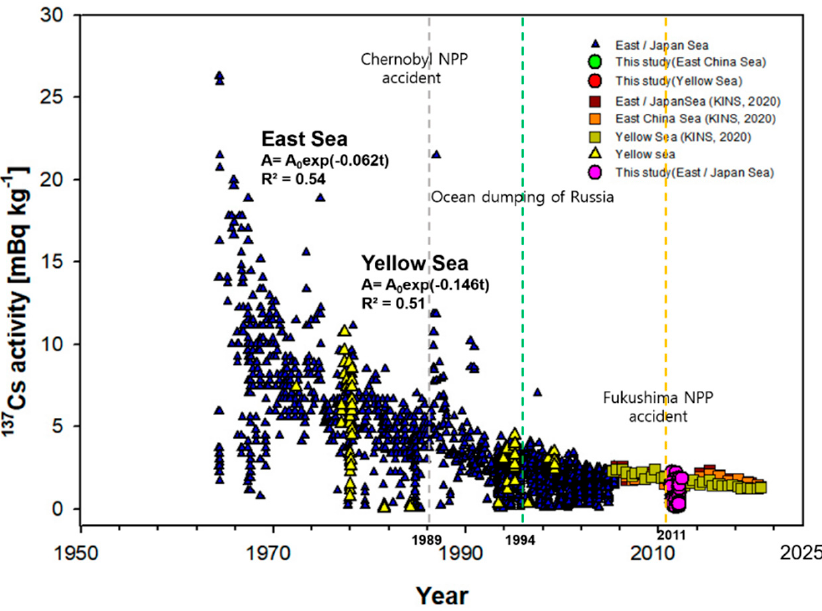
Figure 8. The long-term trends (1960s to present) of 137 Cs activity in the Korean seas. Past data other than those measured in this study were downloaded and applied from the IAEA MARIS (IAEA’s MARine Information System, https://maris.iaea.org/, accessed on 1 September 2022) web database. The environmental removal constant (exponential decrease) to define the environmental half-life was obtained by the coefficient (k) of the best-fitting curve (of exponential decay, A = A 0 (exp( − kt))), (0.146 yr − 1 and 0.062 yr − 1 in Yellow Sea and East/Japan Sea, respectively) The fitting curve equation is calculated by with Sigma–Plot professional 10.0 software.